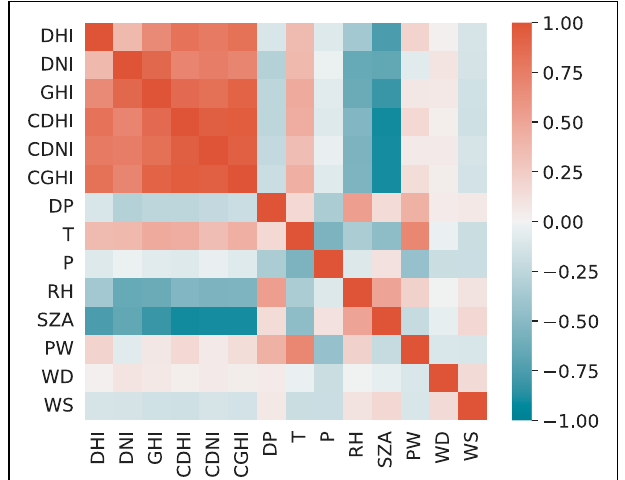
FIGURE 5 | Pearson correlation of meteorological variables. CDHI, clearsky DHI; CDNI, clearsky DNI; CGHI, clearsky GHI; DP, dew point; T, temperature; P, pressure; RH, relative humidity; SZA, solar zenith angle; PW, precipitable water; WD, wind direction; WS, wind